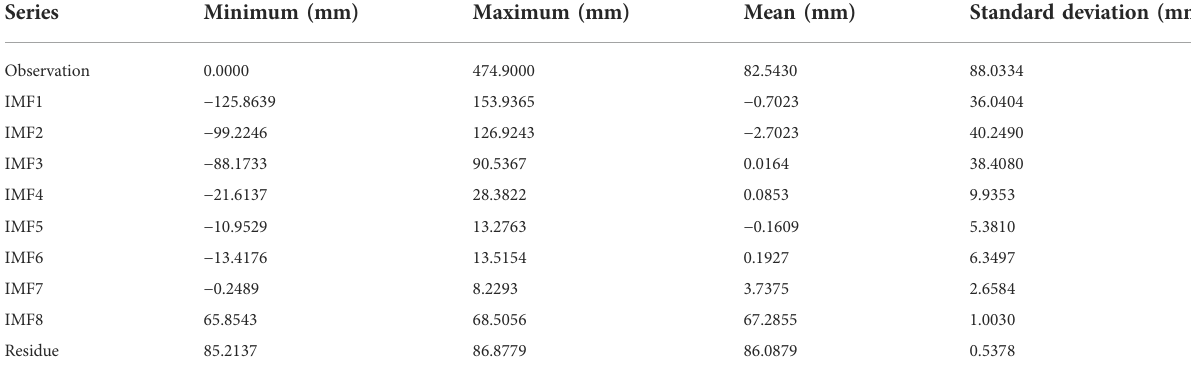
TABLE 1 Descriptive statistics of EEMD decomposition